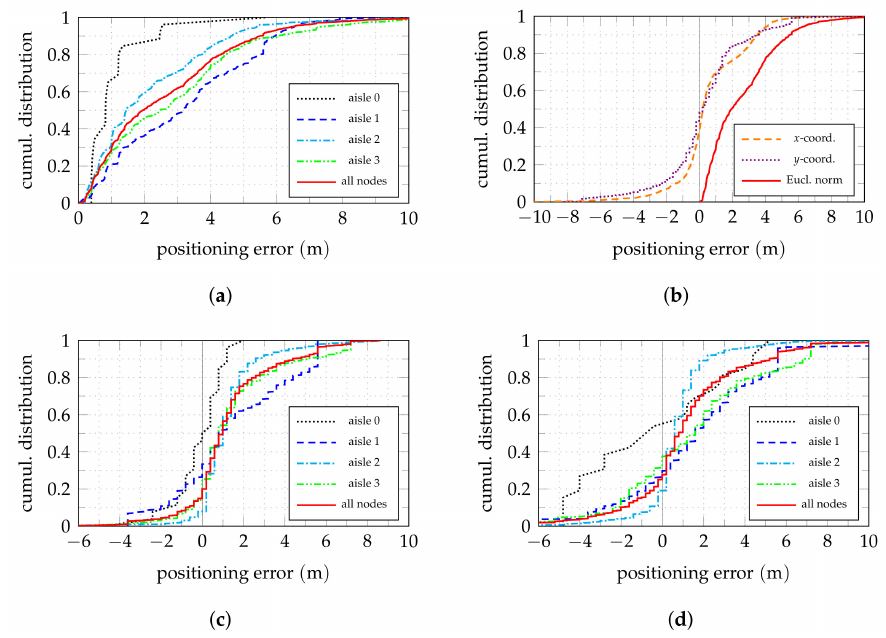
Figure 7. Cumulative positioning error distributions in the horizontal plane using both TDoA and AoA information. In ( a – c ), all anchors are active. ( a ) Shows the Euclidean error norm for all nodes and broken down by aisle. ( b ) Compares the Euclidean to its x and y components. ( c , d ) show the error component orthogonal to the shelf surface for each node. Positive values are distance from the shelf surface towards the middle of the aisle. ( c ) All anchors active. ( d ) Anchors l = 1,3,4